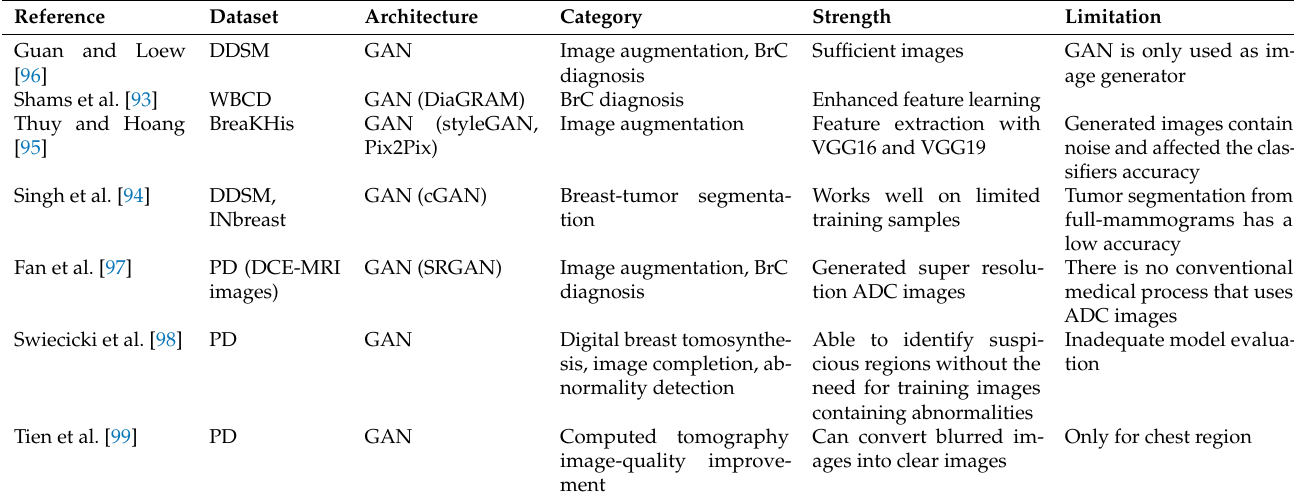
Table 9. State-of-the-art studies based on GAN